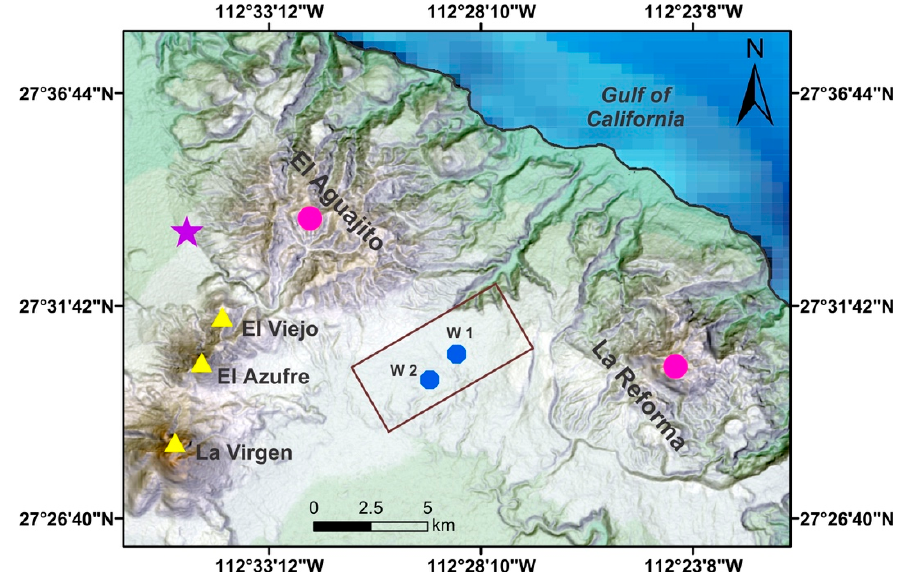
Figure 4. Location of shallow wells drilled (W1 and W2) in La Reforma caldera. The symbology corresponds as follows: Pink-filled circles for La Reforma and El Aguajito calderas, yellow-filled triangles for La Vírgen, El Azufre, and El Viejo volcanoes, and the purple star for a thermal spring called Agua-Agria.